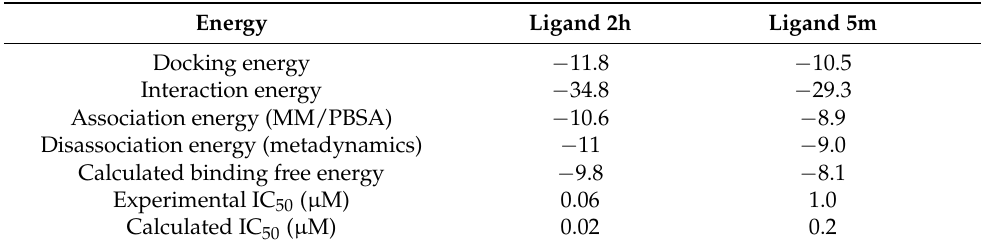
Table 3. Comparison of various energy values (kcal/mol) and IC 50 values for RdRp in complex with ligand 2h and ligand